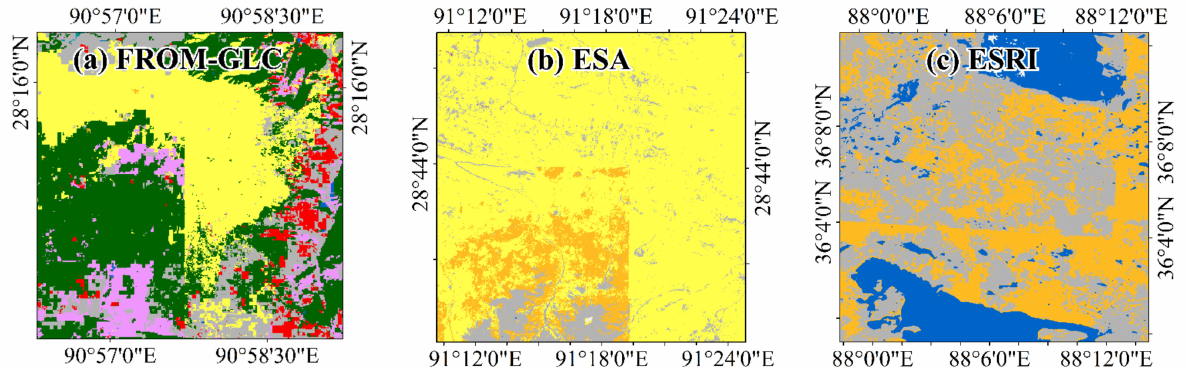
Figure 14. Examples of artefacts in the three LUCC product with sharp boundaries between land cover types: ( a ) FROM-GLC, ( b ) ESA, ( c )